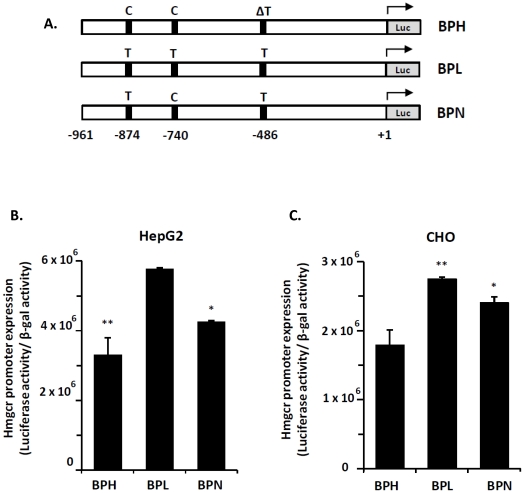
Expression of Hmgcr promoter- luciferase reporter plasmids in cultured cells.
Panel A: Schematic presentation of Hmgcr promoter-luciferase reporter constructs. The locations of promoter SNPs (at −874, −740 and −486 bp) in BPH, BPL and BPN strains are indicated. ΔT shows the deletion of T and −961 indicates the length of promoter used in this study. Panels B and C: Comparison of Hmgcr promoter strengths among BPH, BPL and BPN mice. Promoter reporter constructs harboring −961 to +43 bp region of BPH/BPL/BPN Hmgcr gene were transfected to HepG2 and CHO cells, along with the co-transfected control plasmid pCMV-βGal (β-galactosidase driven by CMV promoter). The cells were assayed for luciferase and β-galactosidase activities 24–30 hrs after transfection. Values shown in the bar graph are the Means ± S.E. of normalized (ratioed) luciferase activity to the β-galactosidase activity from at least three independent experiments. The three strains' transfected promoters displayed significantly different activities in both HepG2 (ANOVA F = 19.955, p<0.01) and CHO (ANOVA F = 12.496, p<0.01) cells as determined by one-way ANOVA with Tukey-Kramer multiple comparisons post-test. In general, the transfected BPL promoter was more active than the BPH promoter while the BPN promoter displayed intermediate expression. (**) and (*) indicate p<0.01 and p<0.05 respectively, compared with BPL in the case of HepG2 cells and compared with BPH in the case of CHO cells.